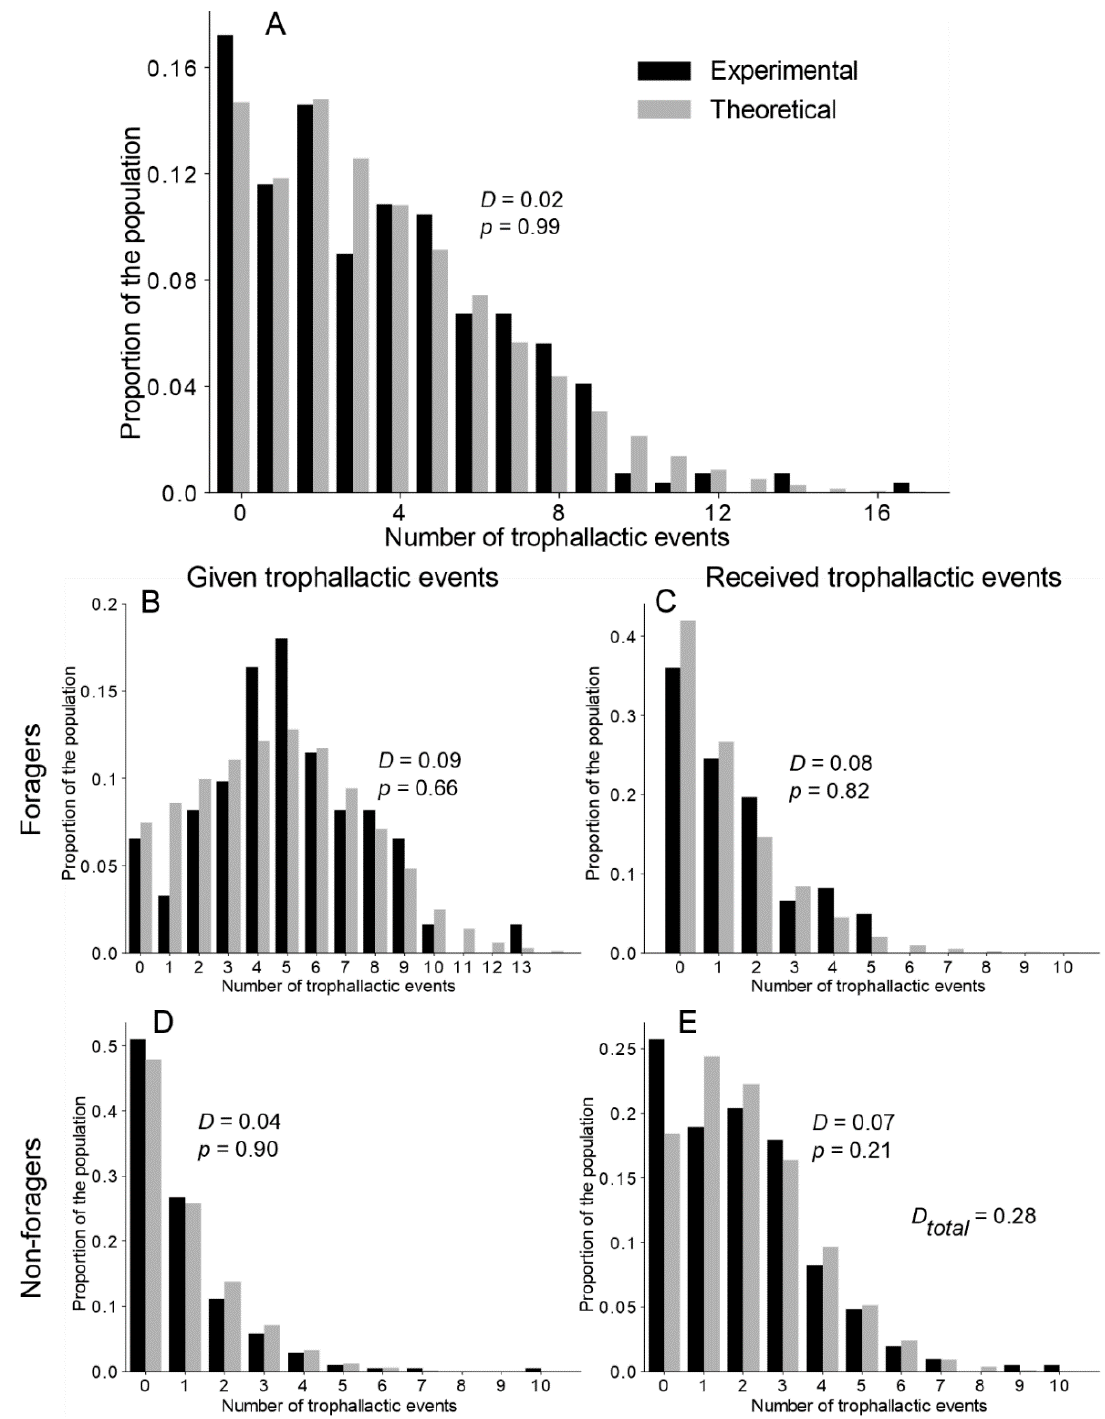
Figure 3. Theoretical and experimental distribution of the number of trophallactic events. ( A ) Distribution of all the trophallactic events at the colony level. ( B , C ) Respectively, the given and received trophallactic events performed by the foragers. ( D , E ) Respectively, the given and received trophallactic events performed by the non-foragers. Theoretical = TEC exponential model. D and p on figures = statistical values from the KS test. D Total = sum of the KS distance ( D ) from the comparison of the distribution in ( B – E ). See Figure S5 and Table S2 for details on the statistical analysis of the other versions of the model.